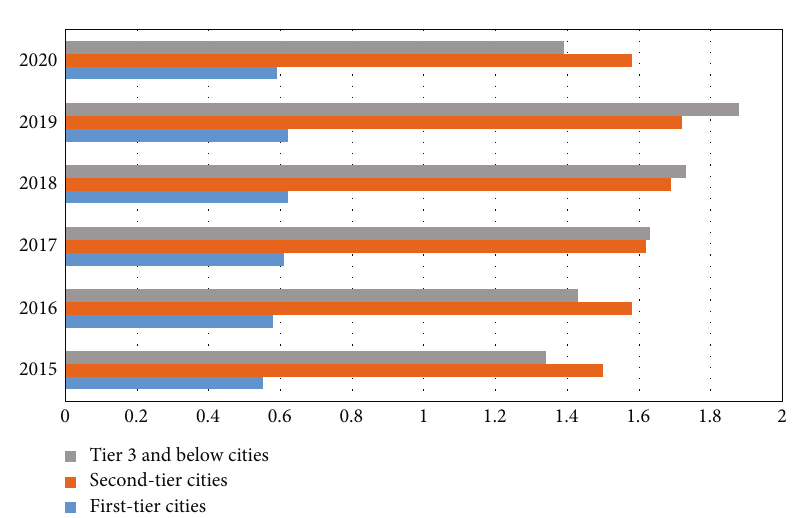
Figure 4: Reward amount.